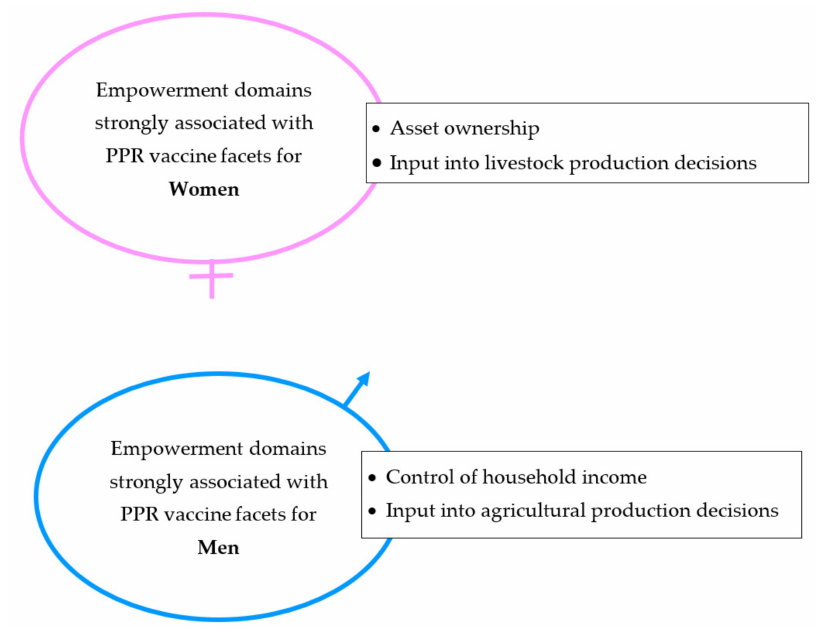
Figure 8. Illustration of the PLS-SEM model results on the empowerment dimensions that were strongly associated with the PPR vaccine